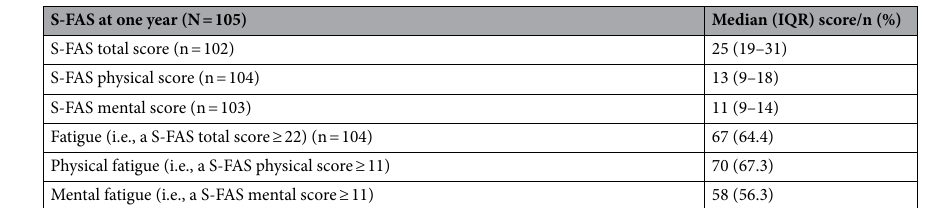
Table 2. The dependent variable, Swedish Fatigue Assessment Scale (S-FAS), at one year after ICU admission following COVID-19. IQR interquartile range, S-FAS the Swedish Fatigue Assessment Scale (FAS) (range 10–50), S-FAS physical score the five S-FAS items that relate to physical fatigue (range 5–25), S-FAS mental score the five S-FAS items that relate to mental fatigue (range 5–25).